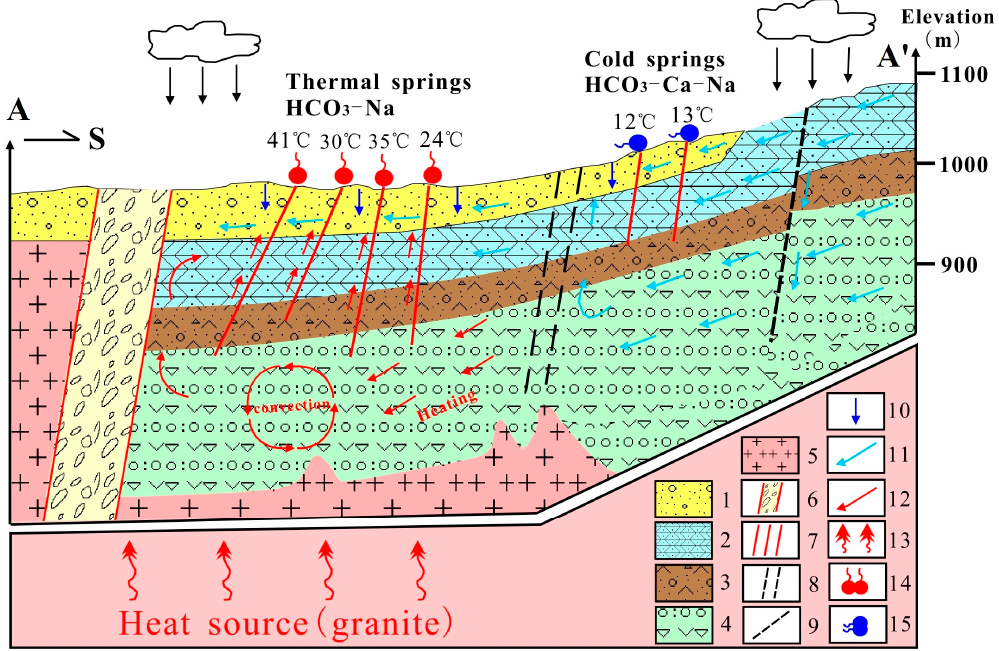
Figure 10. Conceptual model of the Arxan geothermal system: 1, gravel, sand and clay (Quaternary); 2, rhyolitic tuff (Jurassic); 3, tuffaceous conglomerate (Jurassic); 4, tuffaceous breccia (Jurassic); 5, granite (Yanshanian); 6, volcanic conduit; 7, plumose fractures; 8, inferred volcanic conduit; 9, caldera; 10, precipitation infiltration direction; 11, cold water flow direction; 12, geothermal fluid flow direction; 13, heat flux; 14, thermal springs; and 15, mineral springs.